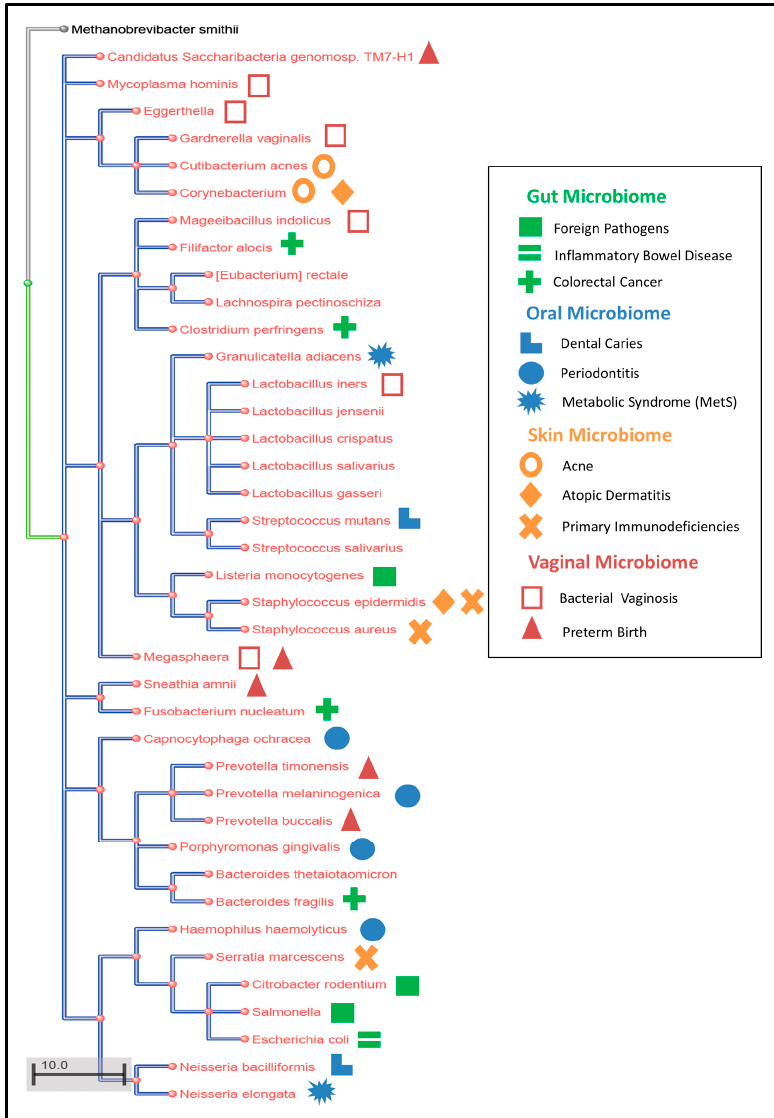
Figure 2. Phylogenetic tree for the all the human microbes present at the 4 antomical sites (gut, oral, skin, vagina). The disease caused by the resident human microbes is shown by a particular